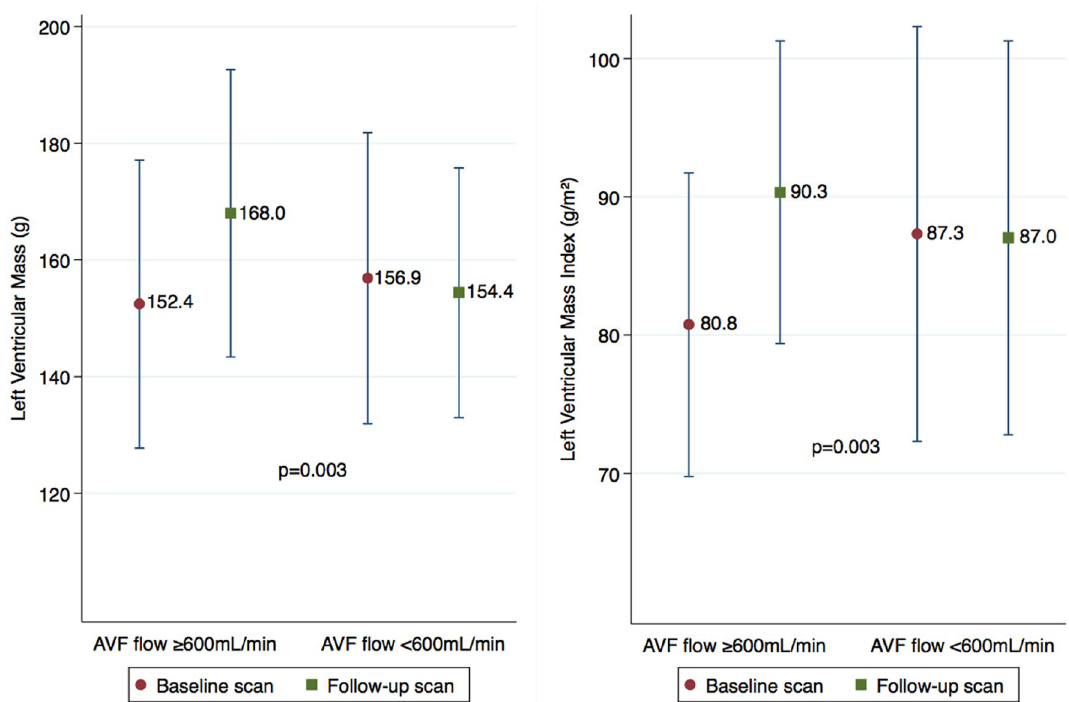
Figure 2. Difference in the means of left ventricular (LV) mass (left) and LV mass index (right) between the 2 scans according to the brachial artery blood flow (p = 0.003 for the difference between groups). This figure shows the means in 40 subjects who completed the second cardiac magnetic resonance scan, 22 with blood flows ≥ 600 mL/min and 18 with blood flows < 600 mL/min. Change in means and the 95% CI show a significant statistical difference between groups (p = 0.003) with an independent